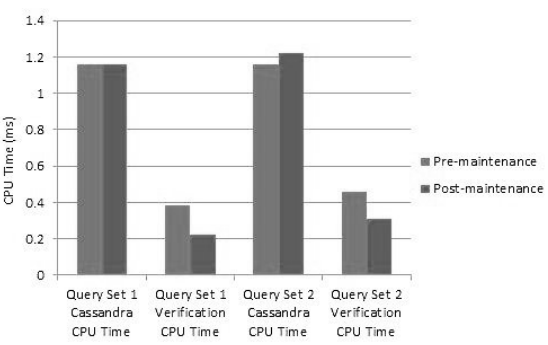
Fig. 7. Xindice Verification data overheads